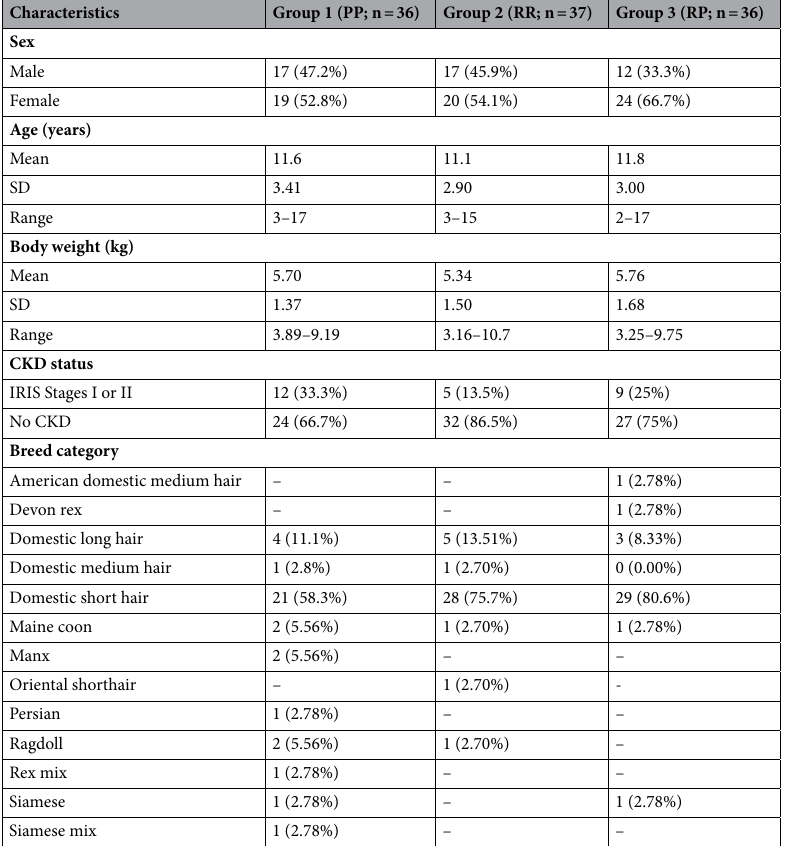
Table 1. Patient demographic data. Sex and breed are presented as count (percentage of treatment group total). Treatment Groups 1–3—lettering designates the medications the patient received during the three treatment periods. P placebo; R robenacoxib, n number of patients, SD standard deviation, CKD chronic kidney disease, IRIS International Renal Interest Society.